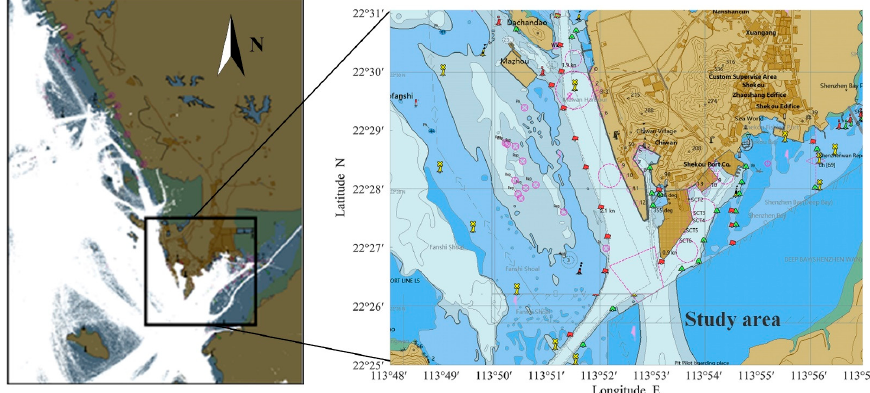
Figure 5. Study area for the diffusion simulation of exhaust gas from multiple ships.